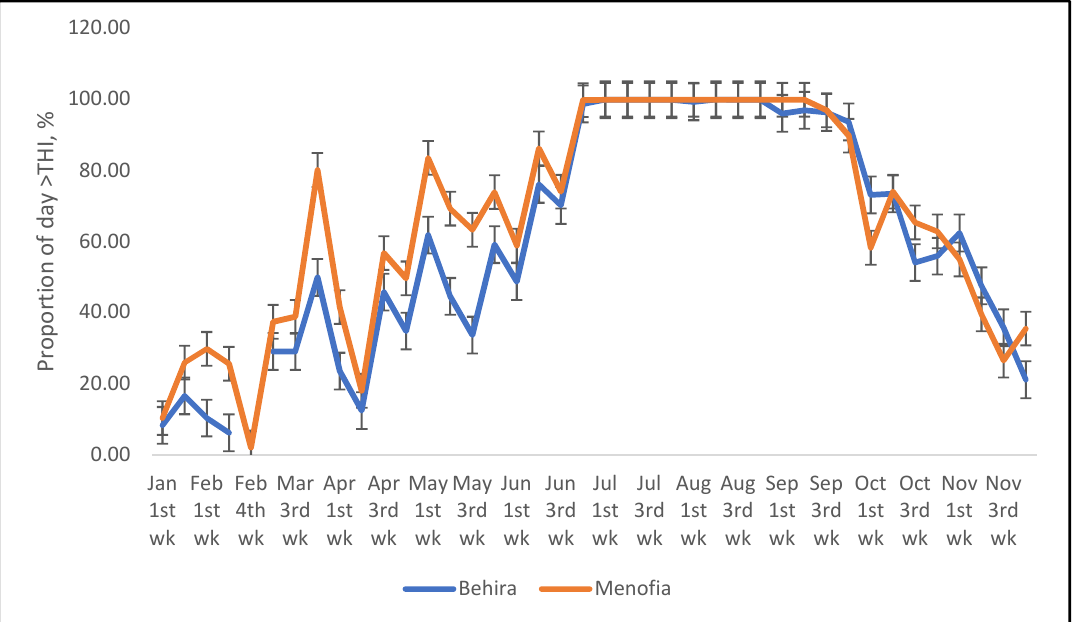
Figure 1. The proportion of half-hour periods in the day that sheep at the two locations (Behira and Menofia) in 2021 experienced THI greater than that believed to cause heat stress.